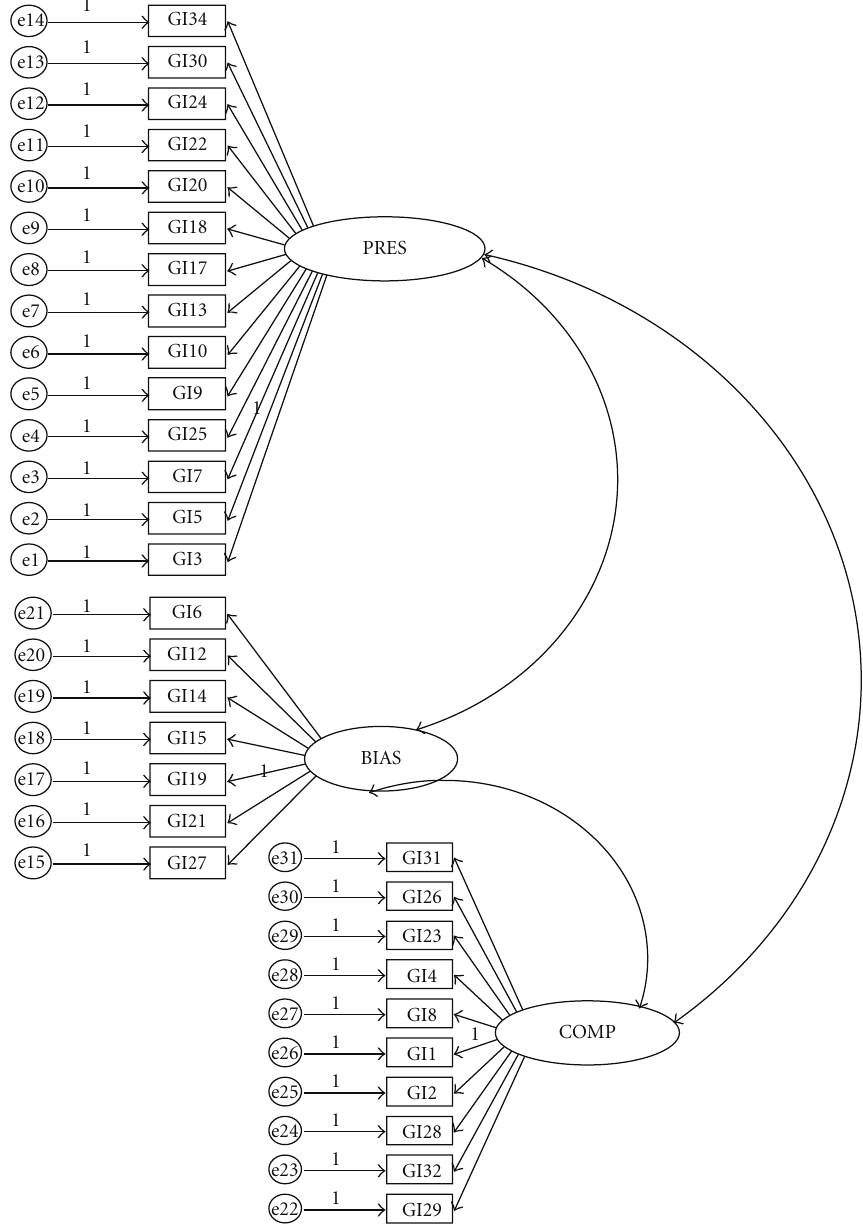
Figure 2: Path diagram for the correlated three-factor model. Note: BIAS: intergroup bias; PRES: felt pressure; COMP: gender compatibility. GI: gender identity measure